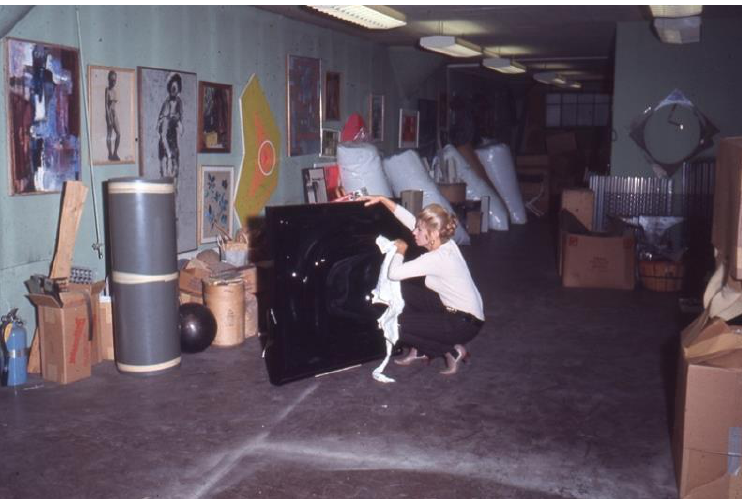
Figure 1 Photographer unknown, Artist Aaronel deRoy Gruber polishing completed vacuum-formed Plexiglas sculpture in her studio at Engineered Products Inc., Pittsburgh, PA. , approximately 1970. Digitized photograph. Image courtesy of the Irving and Aaronel deRoy Gruber Foundation, Pittsburgh.